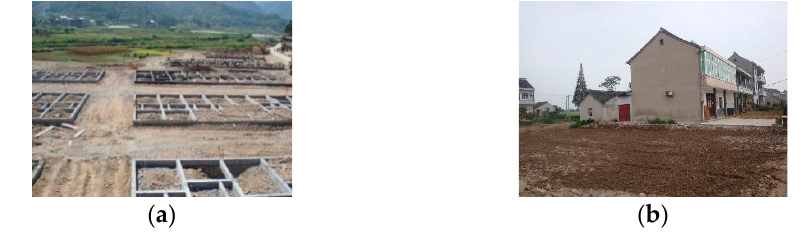
Figure 11. Spatial forms of homesteads: ( a ) homesteads without buildings; ( b ) homesteads with buildings.